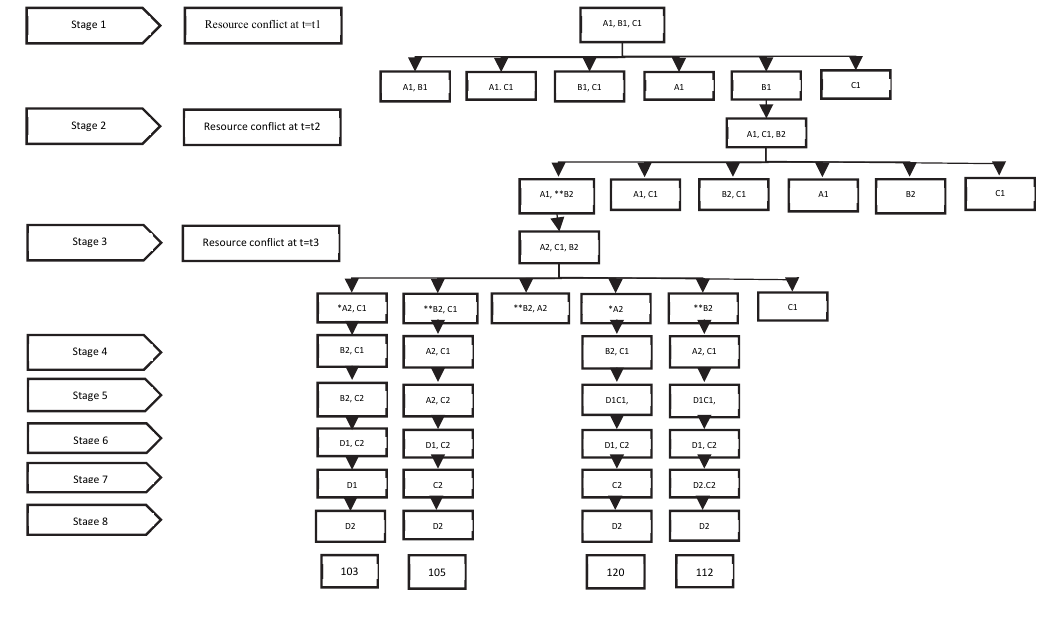
Fig. 5. Project schedule